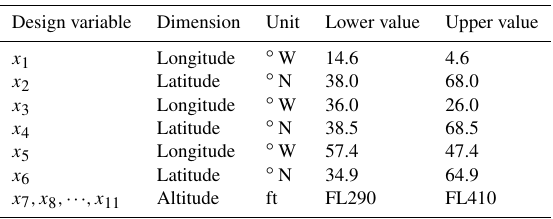
Table 6. Lower/upper bounds of the 11 design variables. Design